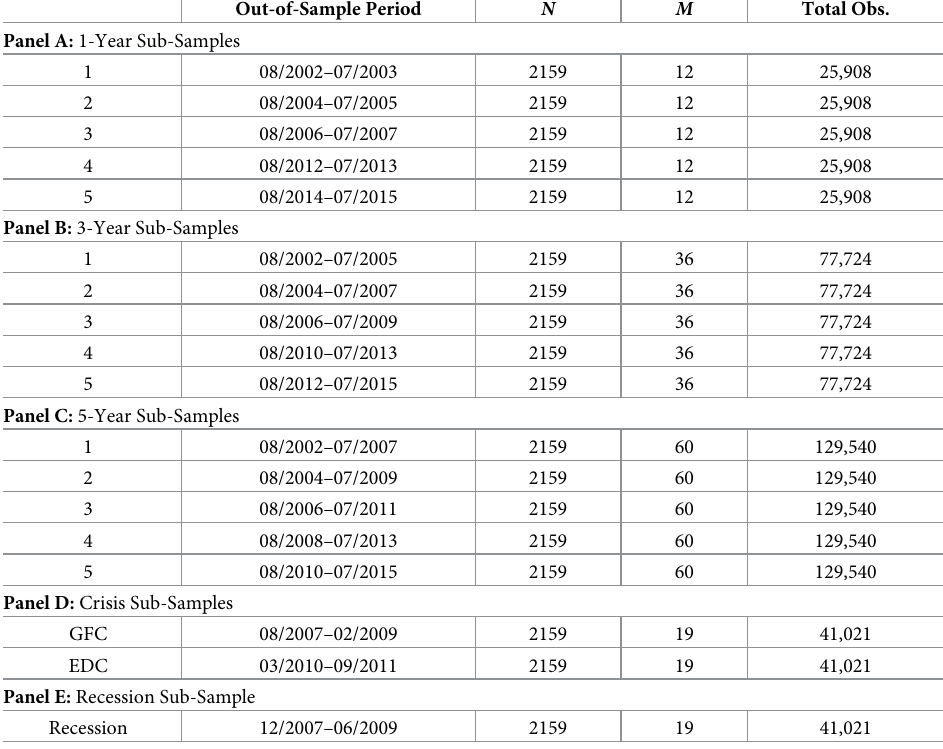
Out-of-Sample Period N M Total Obs. Panel A: 1-Year Sub-Samples